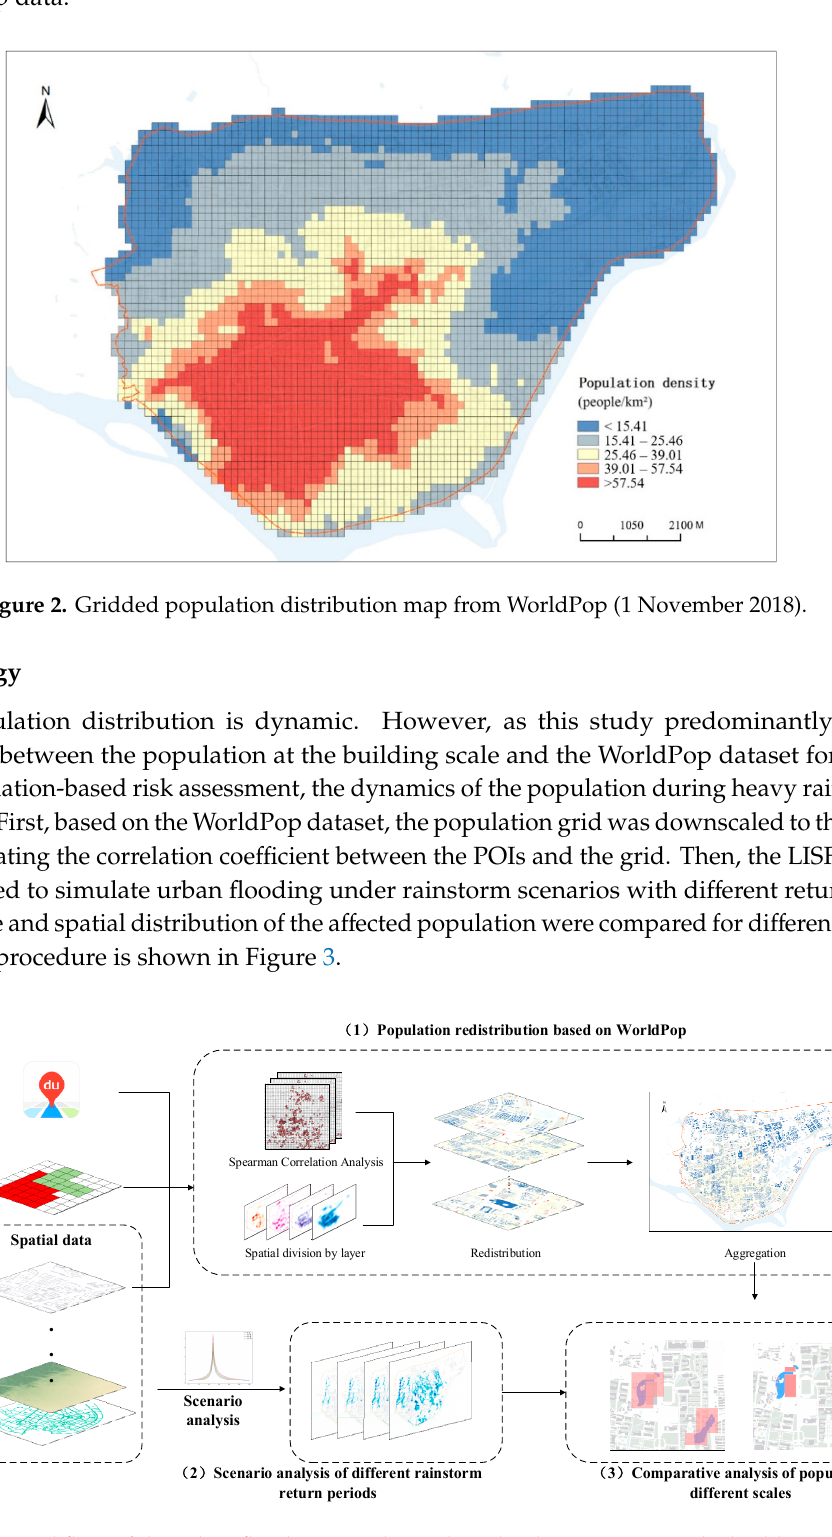
Figure 3. Workflow of the urban flooding population-based risk assessment at the building